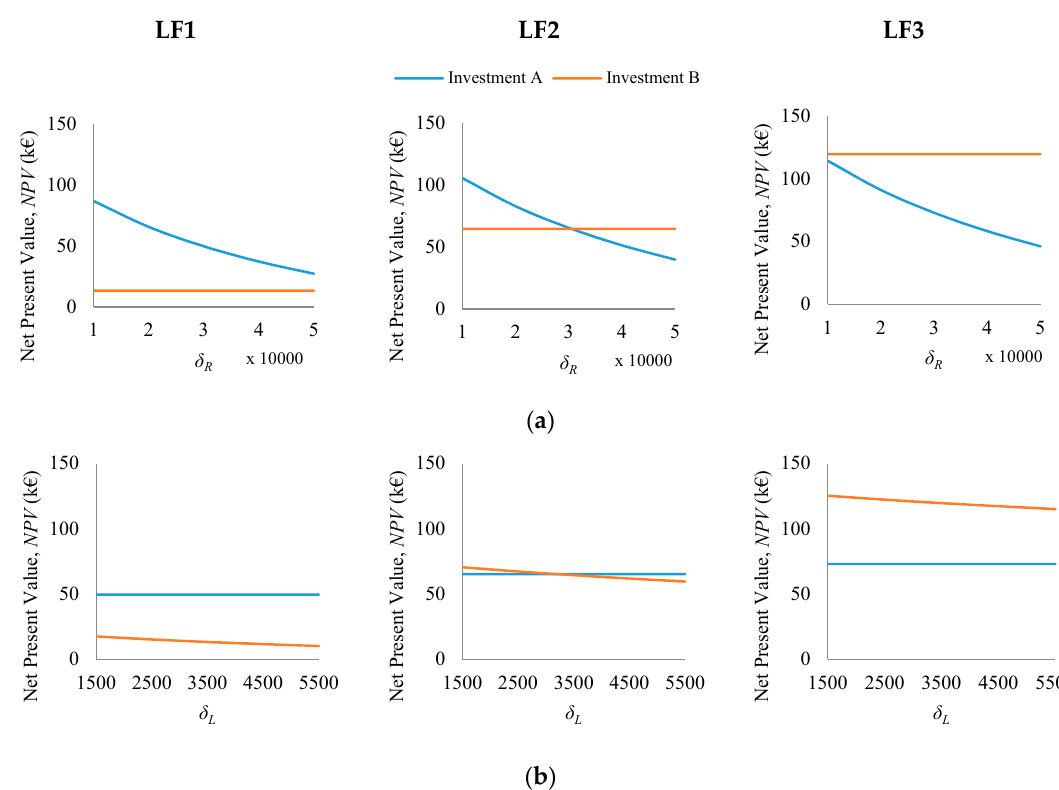
Figure 7. Sensitivity analysis on the expected NPV of the investments in “SEC reduction” (Investment A), and “SEC levelling” (Investment B) for the different load factors with respect to the parameters of the logarithmic investment function: i.e., ( a ) δ R , and ( b ) δ L .